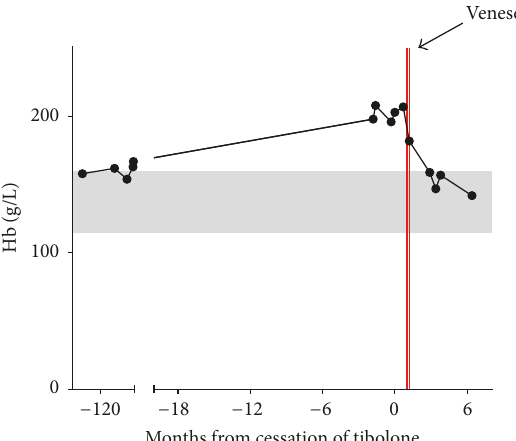
Figure 1: Hb results are depicted from over ten years prior to the cessation of tibolone and for over 6 months after the cessation of tibolone. The grey shaded area represents the reference range for normal